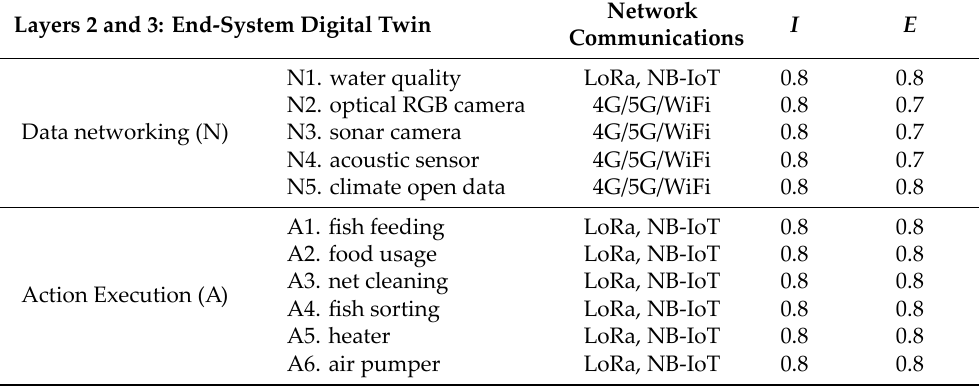
Table 2. Layers 2 and 3 of the Digital Twins send sensor data to the cloud storage or execute actions defined by decision‑making